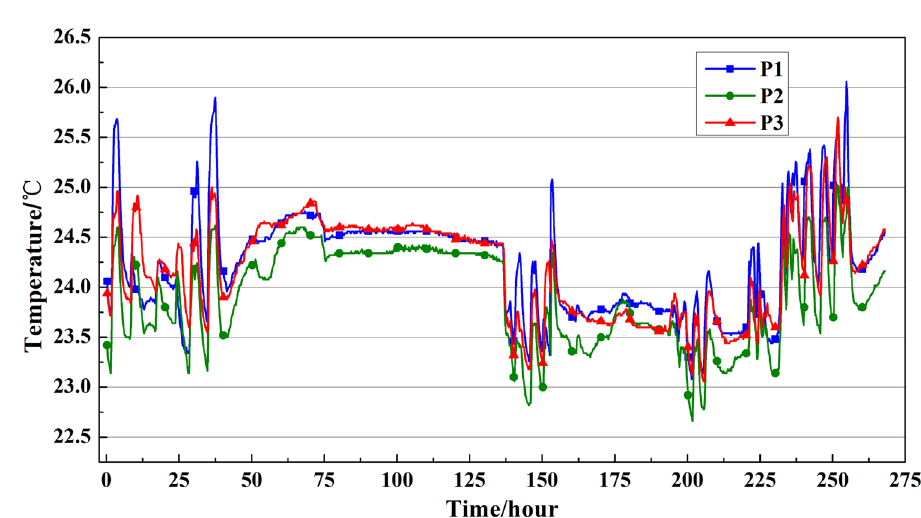
Figure 13. P1 P2 and P3 temperature data from April 9th to April